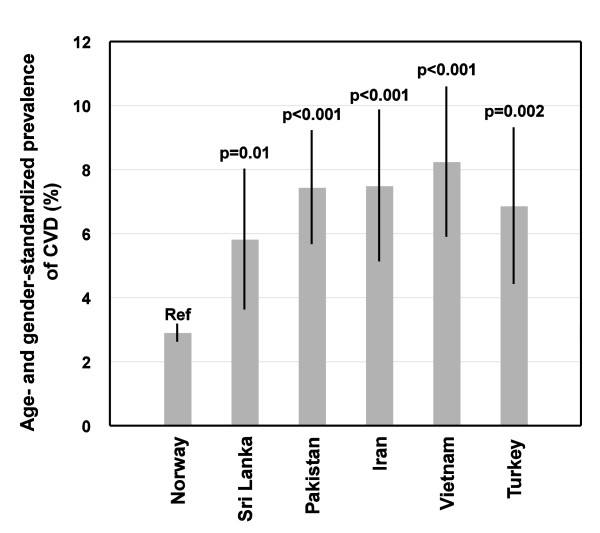
Prevalence (% with 95% CI) of self-reported cardiovascular disease (CVD) by ethnicity. Bars: CVD prevalence, |: 95% CI, p-value: ethnic difference in CVD prevalence between the particular ethnic group and the Norwegian reference group (ref).